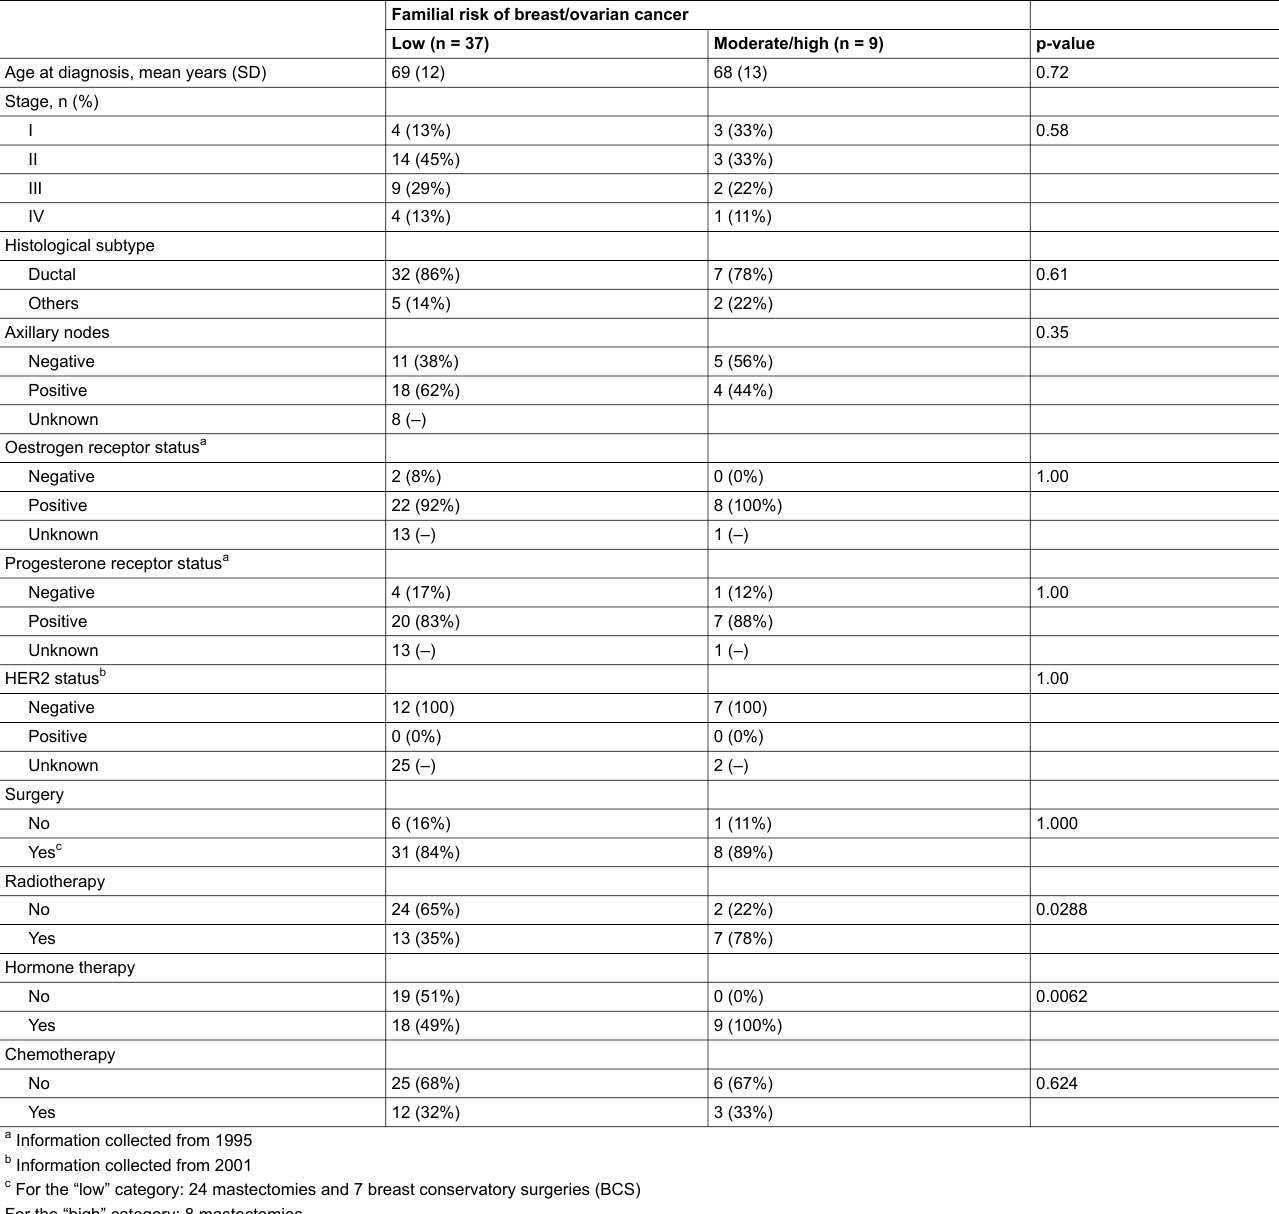
Table 1 : Characteristics of men with breast cancer according to family history of breast cancer.